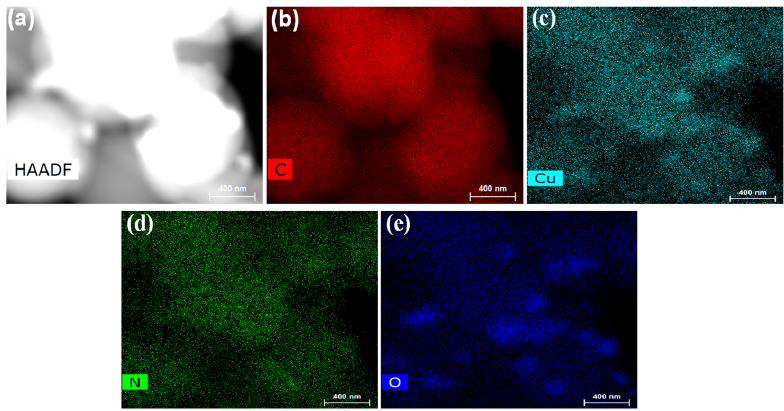
Figure 2. ( a ) HAADF-STEM image of Cu–CNSs. ( b – e ) EDS elemental mapping images of Cu–CNSs displaying distribution of C, Cu, N, and O. Scale: 400 nm.